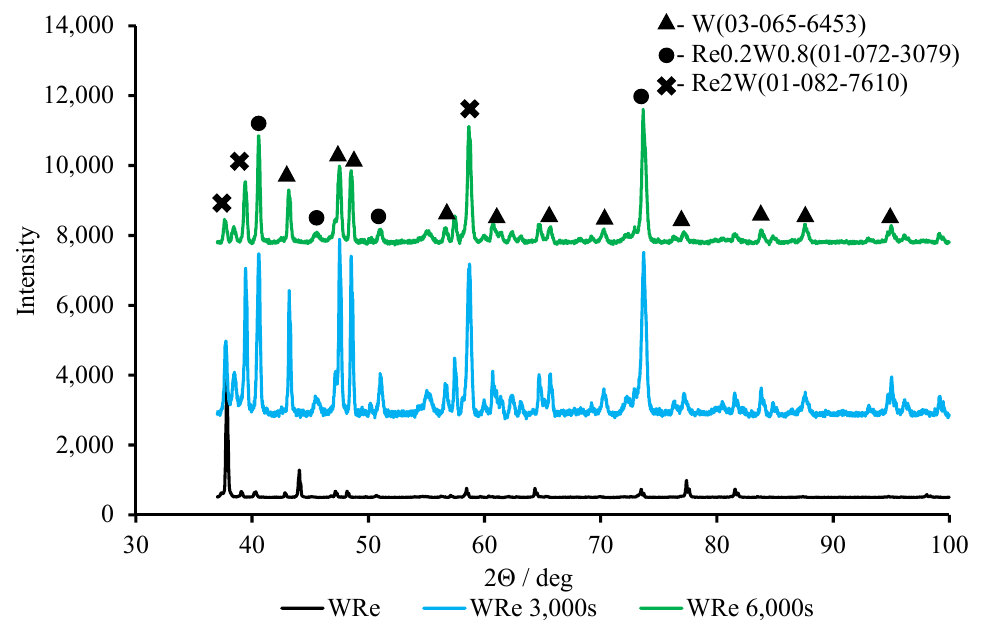
Figure 3. Diffractograms of initial alloy, alloy after 3000 s exposure in the solution, and alloy after 6000 s exposure in the solution.